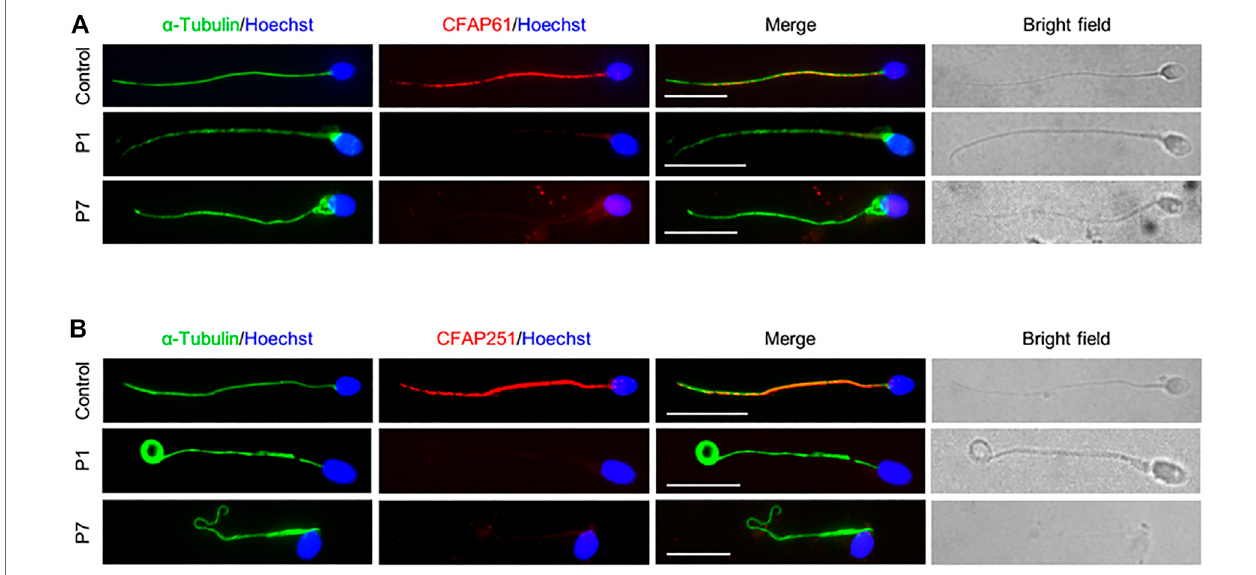
FIGURE 3 | CSC proteins were not observed in sperm fl agella of patients. Representative images of spermatozoa from a fertile control, P1, and P7 co-stained by anti- α -Tubulin antibodies and anti-CFAP61 antibodies (A) or anti-CFAP251 antibodies (B) . Scale bars represent 10 μ m.